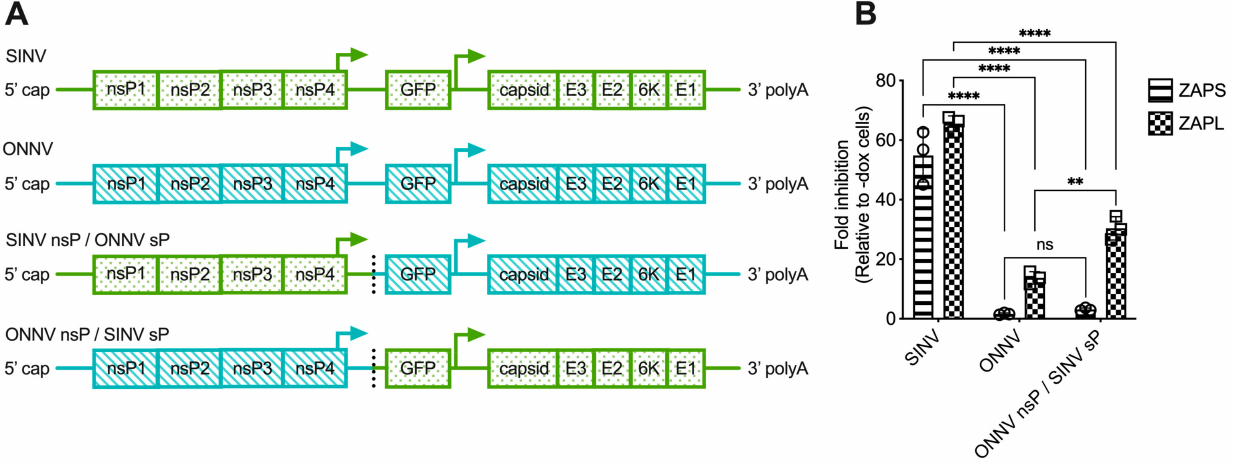
Figure 4. The alphavirus nsP gene region contains the ZAP sensitivity determinant. ( A ) Schematics of chimeric viruses generated. The GFP construct is the same across all viruses. ( B ) ZAP KO 293T cells with doxycycline-inducible expression of ZAPS or ZAPL were infected with GFP-expressing SINV, ONNV, or ONNV nsP/SINV sP chimeric virus at MOI = 0.1 PFU/cell for 18 h before their percentage of infection was determined by flow cytometry. Fold inhibition by ZAP relative to doxycycline-untreated (-dox) cells is shown here. Error bars represent the SD. Data representative of two independent experiments performed with biological replicates in triplicate wells. Asterisks indicate statistically significant differences (two-way ANOVA and Tukey’s multiple comparisons test: **, p < 0.01; ****, p < 0.0001). ns—not